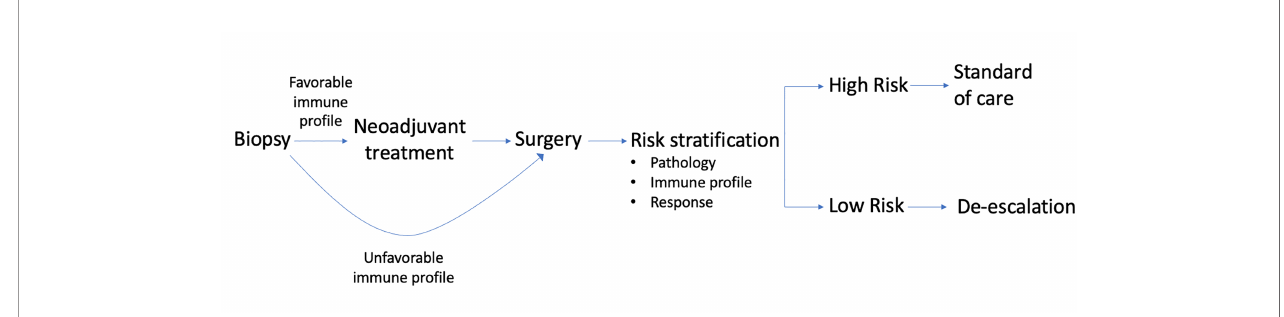
FIGURE 3 | Immune pro fi le of biopsied tumor can indicate need for preoperative immunotherapy in OCSCC. After de fi nitive surgery, risk strati fi cation can be done using pathologic data, immune pro fi le, and response to initial treatment. Level of risk can then dictate